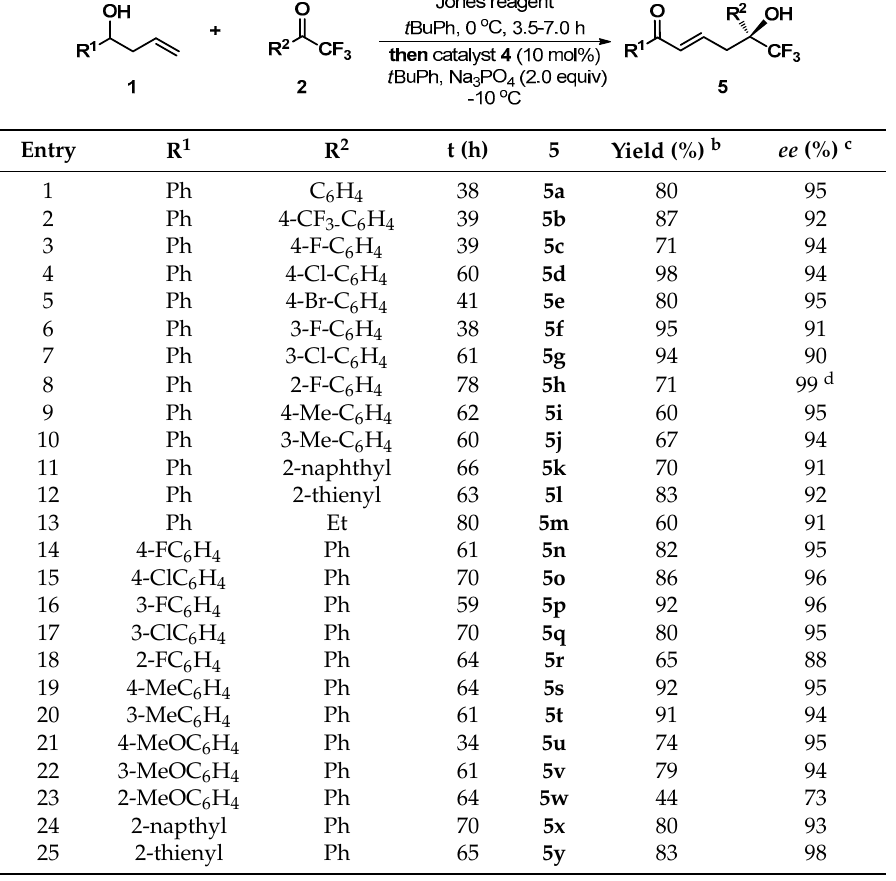
Table 2. One-pot tandem reactions between homoallylic alcohols 1 and trifluoromethyl ketones 2 a .